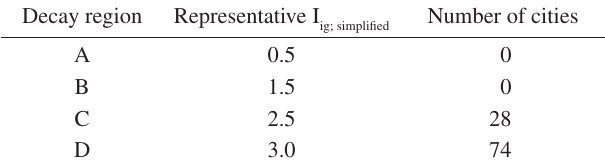
Table 7. Representative climatic index for four classes of aggressiveness.